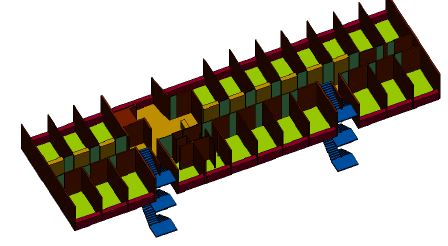
Figure 7. 3D model of OTB